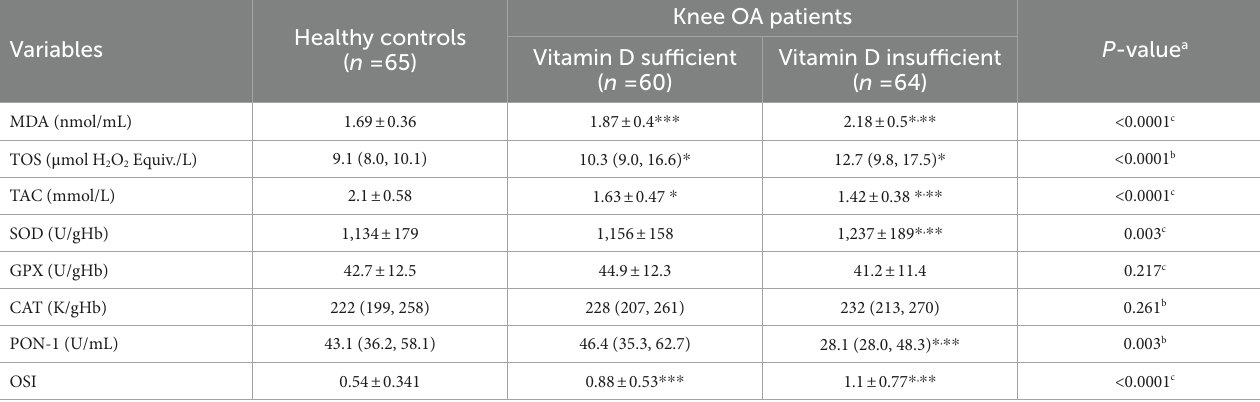
TABLE 2 Oxidative stress markers in healthy controls and patients with knee osteoarthritis according to vitamin D status. Variables